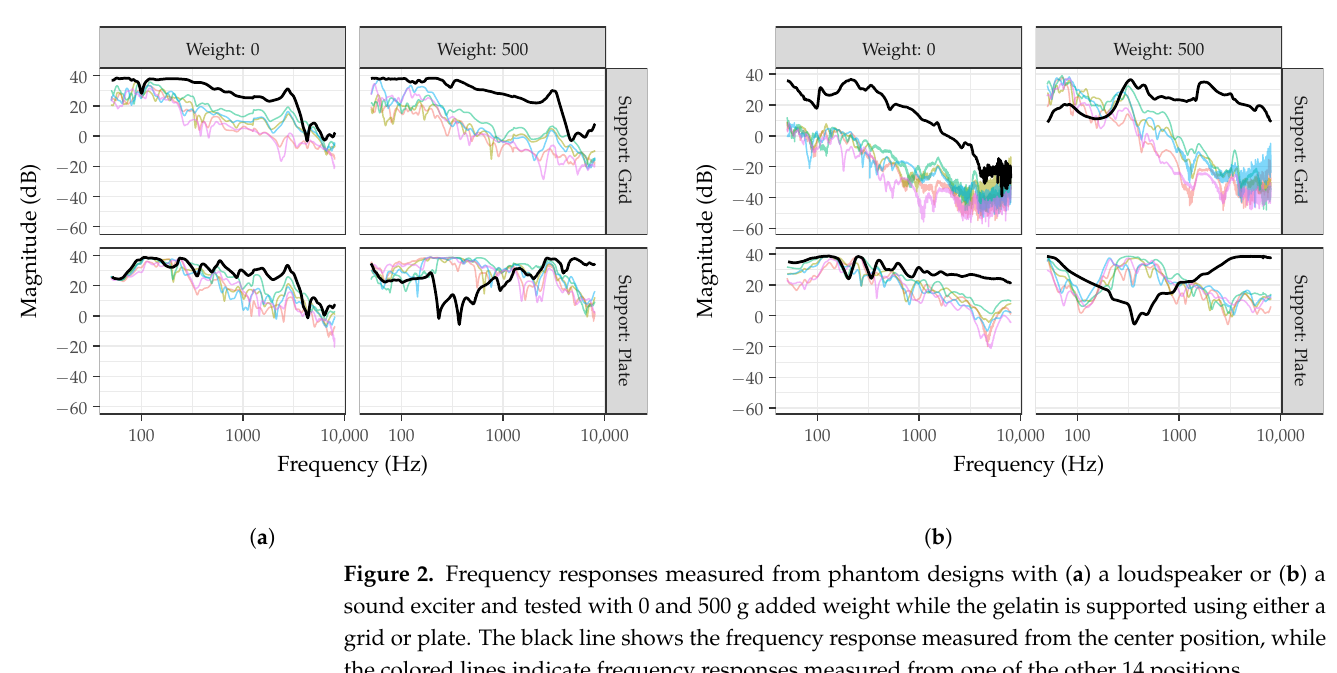
Figure 2. Frequency responses measured from phantom designs with ( a ) a loudspeaker or ( b ) a sound exciter and tested with 0 and 500 g added weight while the gelatin is supported using either a grid or plate. The black line shows the frequency response measured from the center position, while the colored lines indicate frequency responses measured from one of the other 14